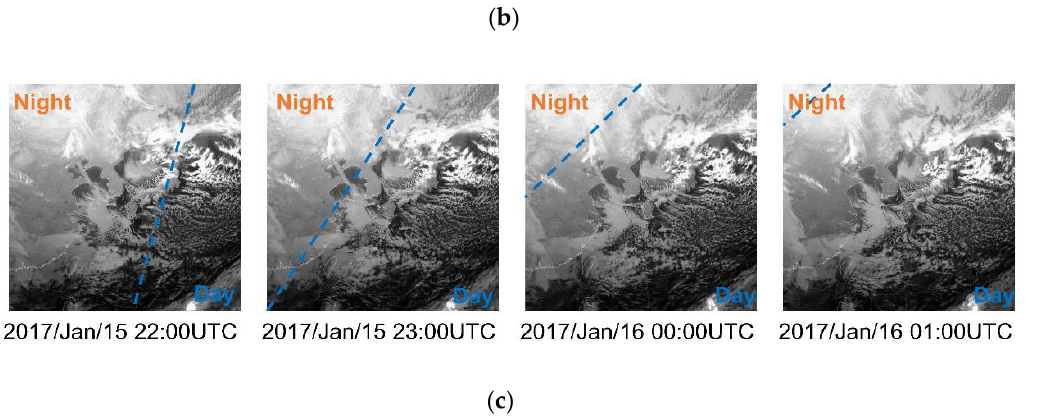
Figure 8. ( a ) Time series of the real COMS MWIR reflectance, ( b ) the AI-generated COMS MWIR reflectance, and ( c ) the AI-generated COMS MWIR radiance during the twilight. The time period was January 15, 2017, 22:00 UTC to January 16, 2017, 01:00 UTC.